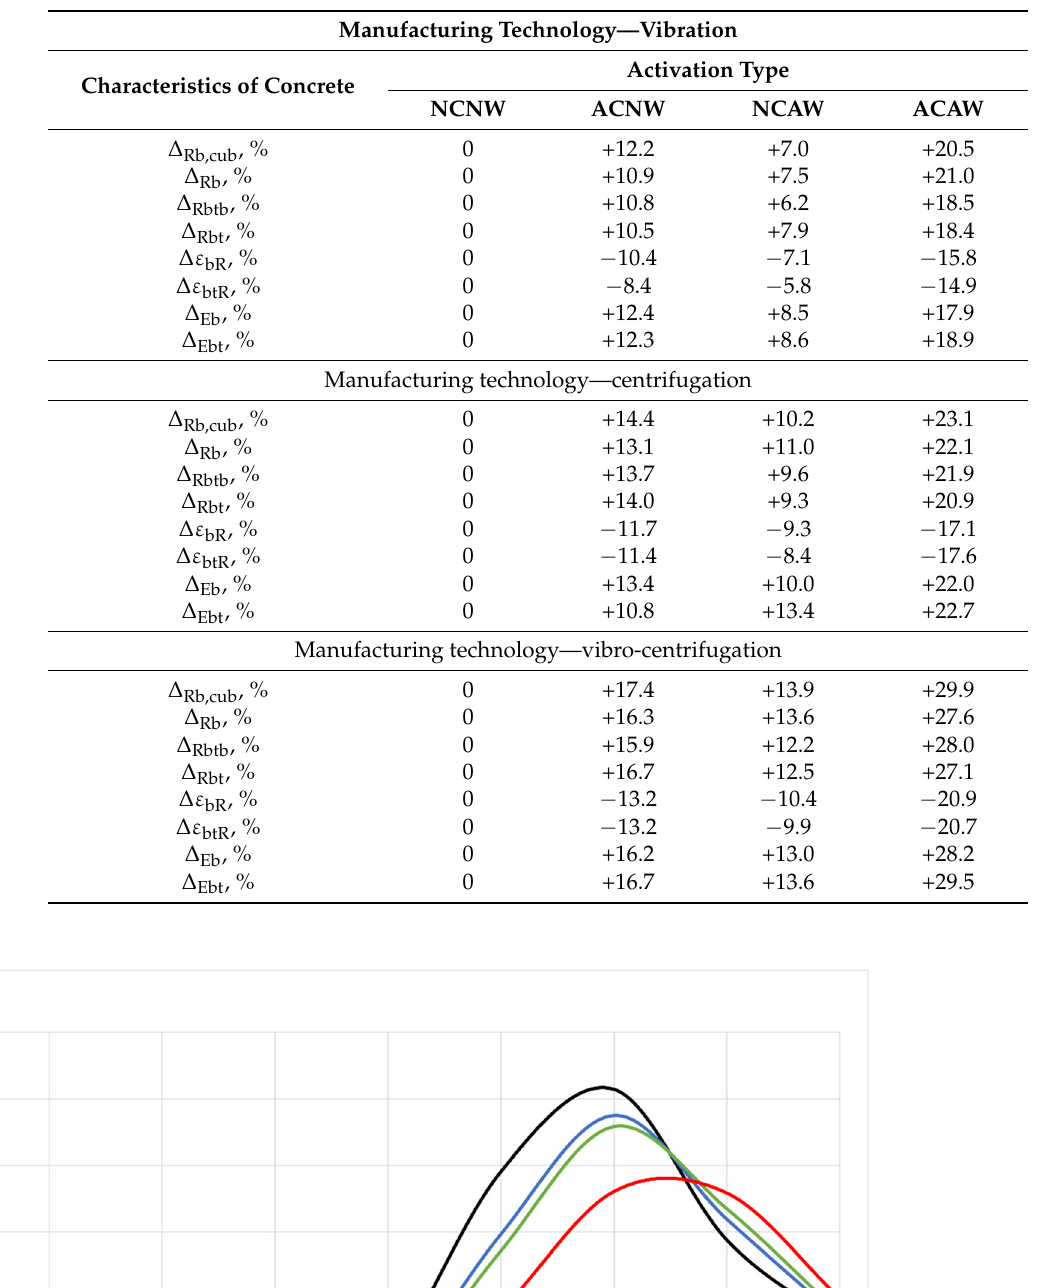
Table 8. Changes ( ∆ ) of strength and strain characteristics of concrete for various types of activation and manufacturing technology.